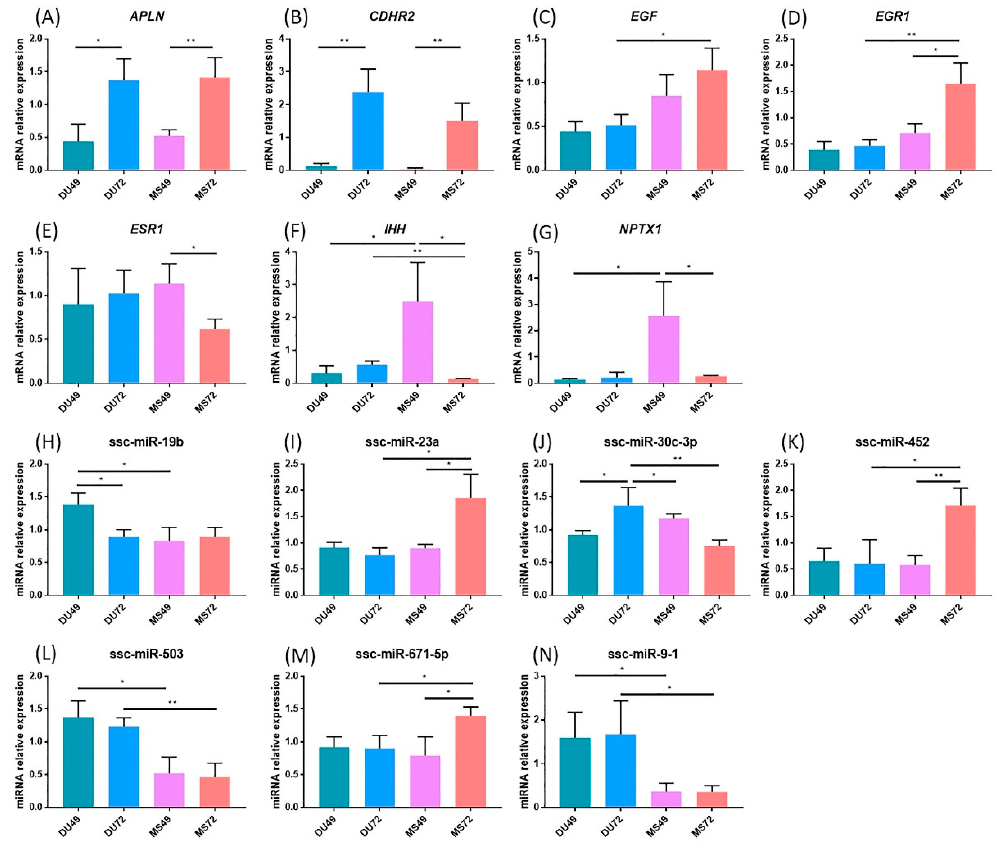
Figure 8. Quantitative PCR validation. The x-axis represents the different stages and breeds and the y-axis shows the fold changes in expression (* p < 0.05, ** p < 0.01). ( A ) APLN ; ( B ) CDHR2 ; ( C ) EGF ; ( D ) EGR1 ; ( E ) ESR1 ; ( F ) IHH ; ( G ) NPTX1 ; ( H ) ssc-miR-19b; ( I ) ssc-miR-23a; ( J ) ssc-miR-30c-3p; ( K ) ssc-